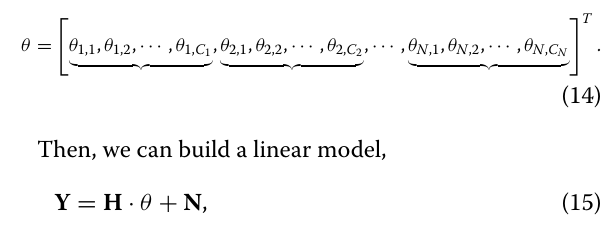
design set is a subset of the full-factorial design set and includes the most significant factors of configurations.